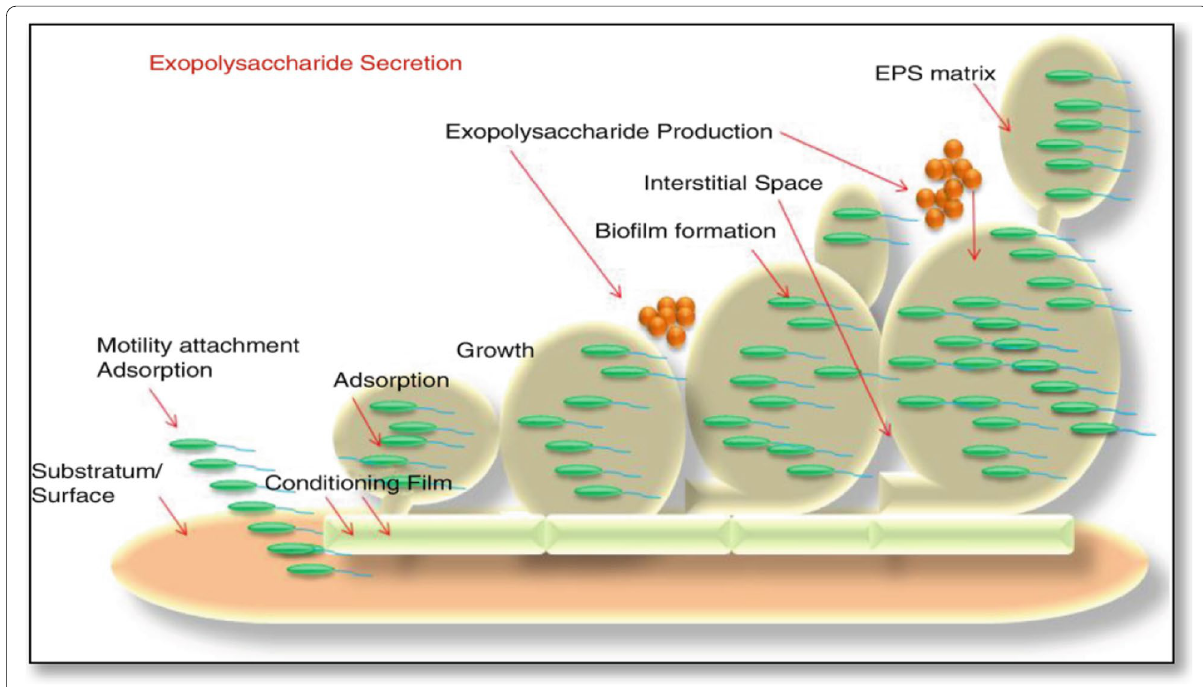
Fig. 6 General steps involved during the formation of the exopolysaccharide matrix of a